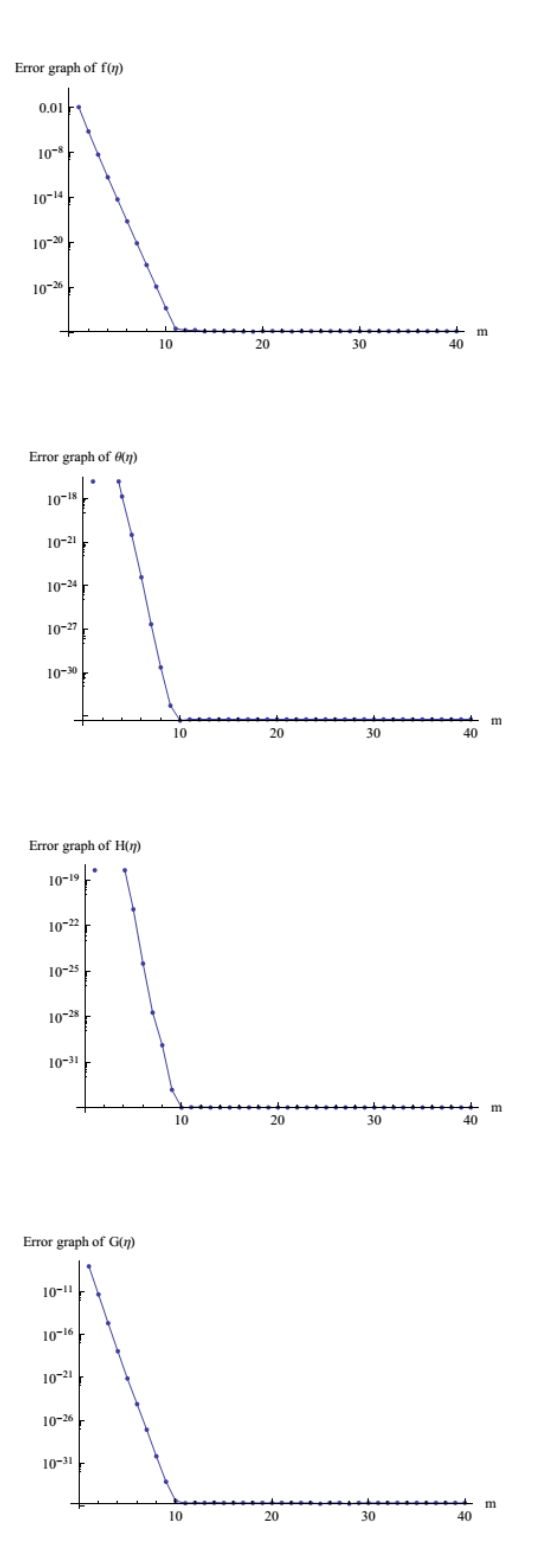
Figure 2. Illustration of the error profiles of f ( η ) , θ ( η ) , G ( η ) and H ( η ) with fixed values of Pr = − 0.5, S = − 0.5, L = 0.01, Q = 5, R = 0.7, δ = 1, Sc = 2.5, K 1 = 0.1, K 2 = 1 and Ha =